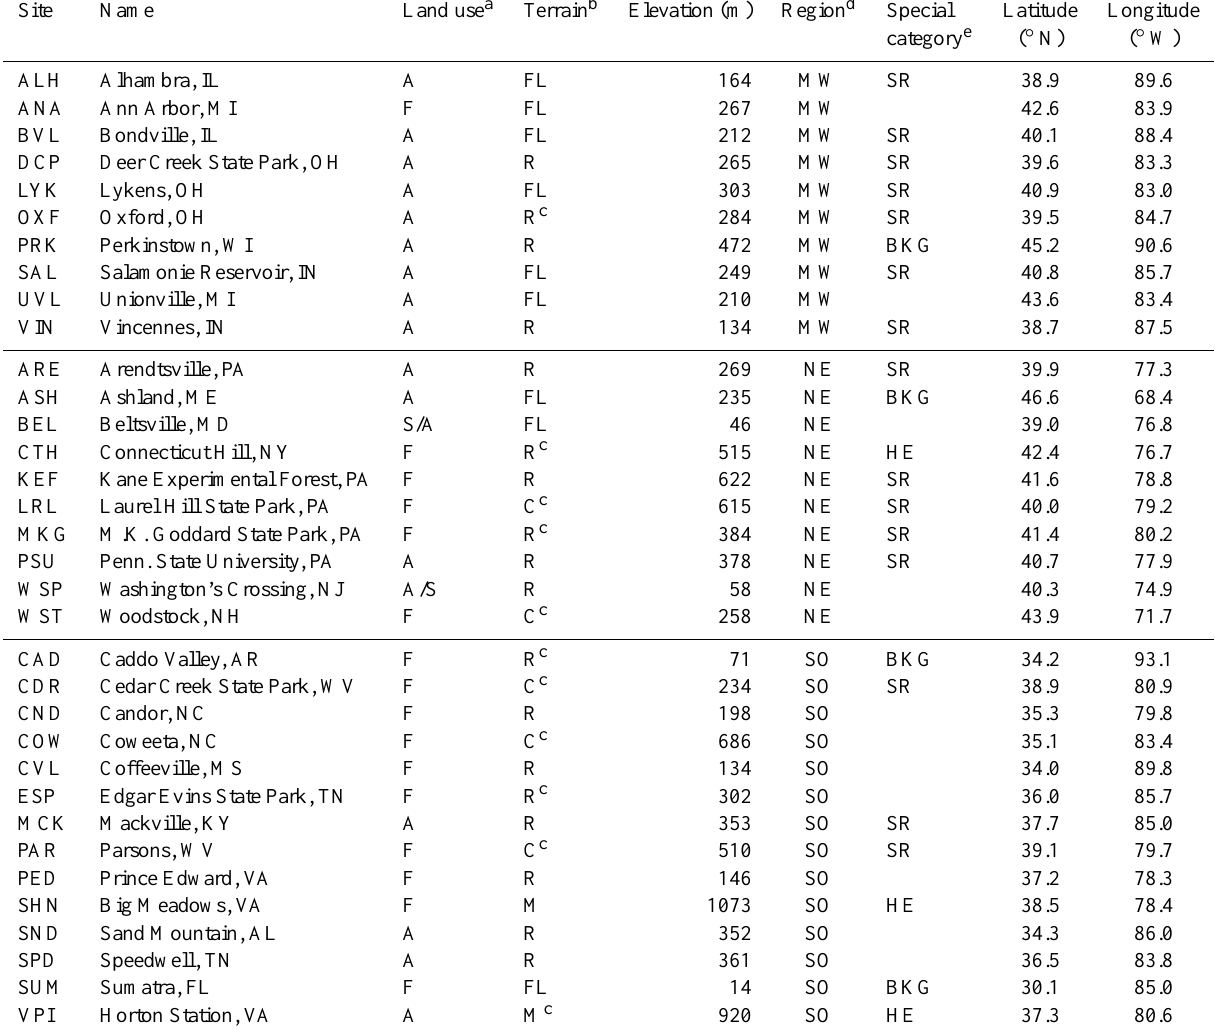
Table 1. Summary of characteristics of 34 CASTNET monitoring sites providing data in current study (see Fig. 2) listed by region.